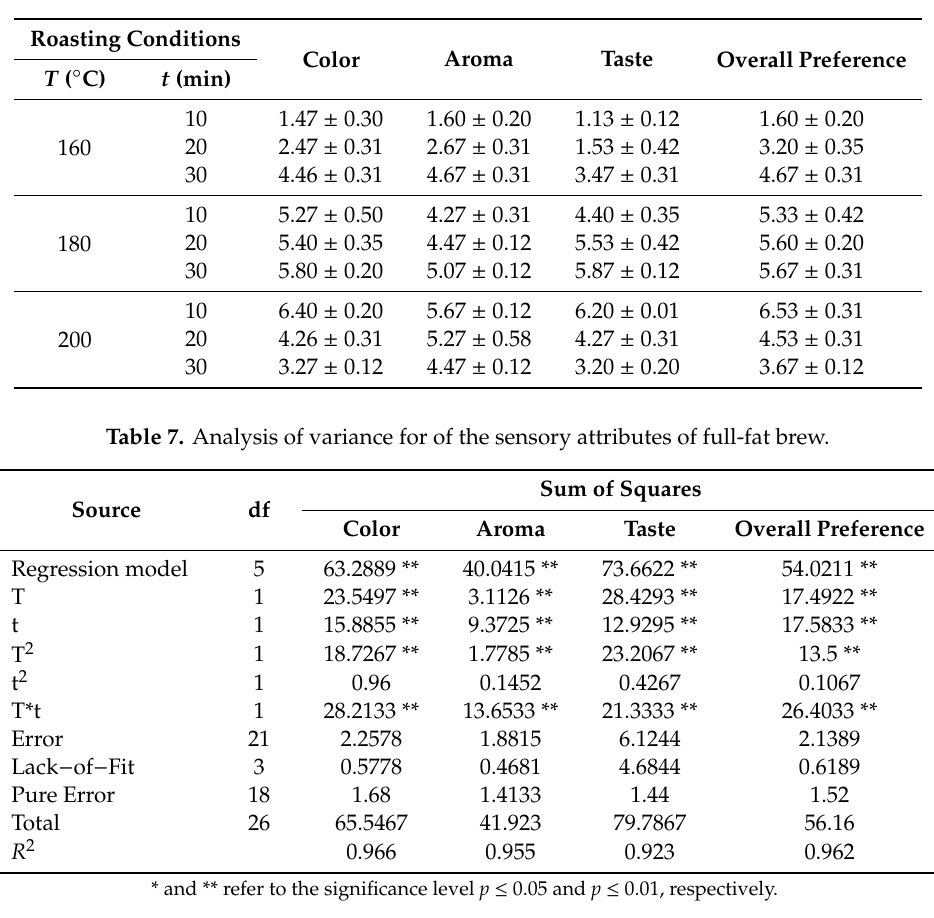
Table 6. Means and standard deviations of sensory attributes of co ff ee-like brew from full-fat roasted date seeds as a function of roasting temperature and time.